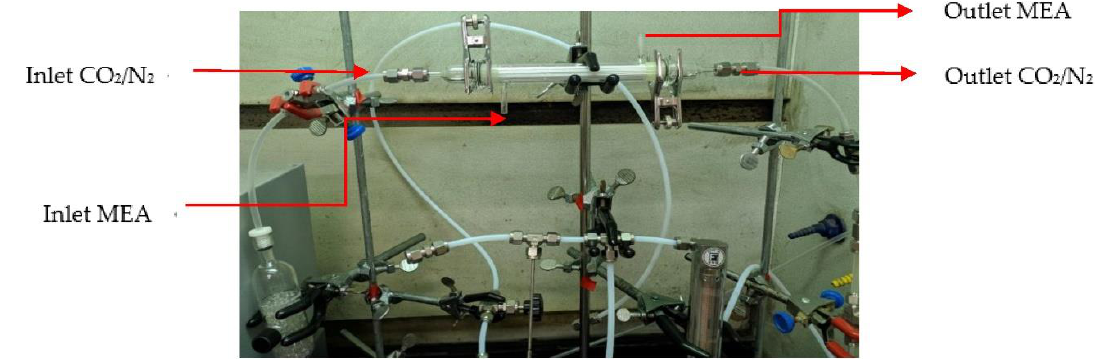
Figure 4. Photo of the experimental setup for the CO 2 absorption membrane module.